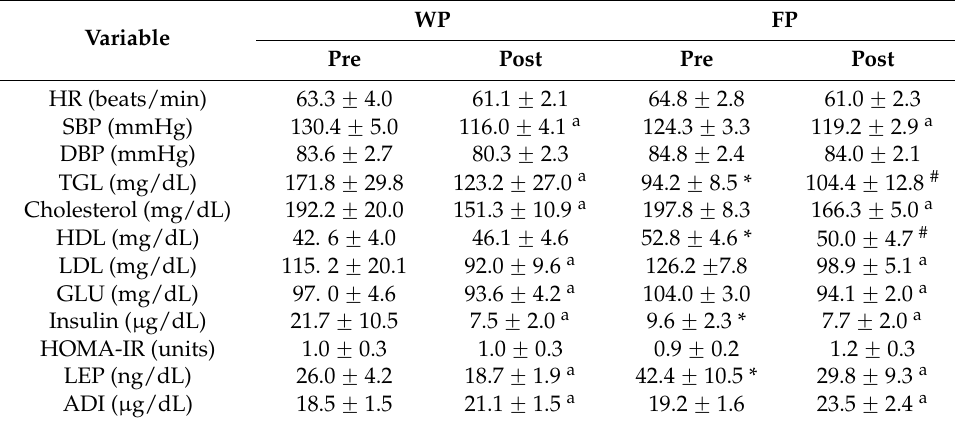
Table 3. Cardiometabolic markers at baseline and